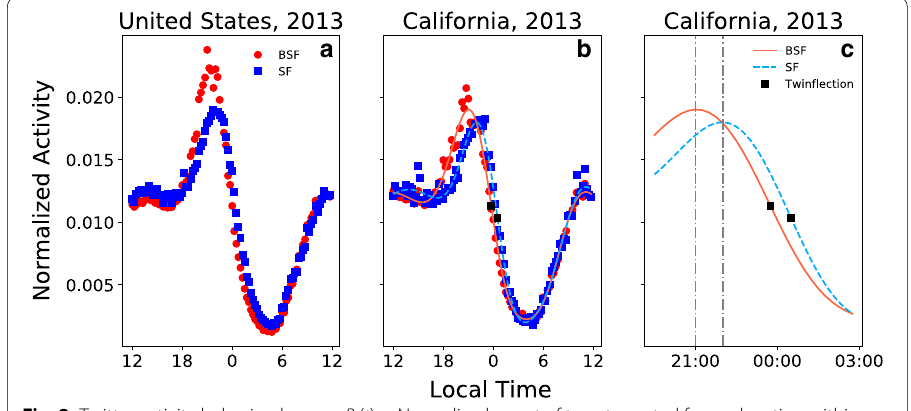
Fig. 2 Twitter activity behavioral curves B ( t ). a Normalized count of tweets posted from a location within the United States between 12 p.m. Sunday and 12 p.m. Monday before (red) and the week of (blue) the 2013 Spring Forward Event. The time recorded for the tweet is that local to the author. Though the pattern of behavior is preserved following Daylight Savings, peak activity is translated forward in time. b The same plot, with location of tweet origin restricted to the state of California. California is the state for which we have the most data, and therefore the most representative behavior profile after smoothing with Gaussian Process Regression (lines). We note that Fig. 5 shows behavioral curves for all states. c The smoothed behavioral pattern for California during the hours of 9 p.m. to 3 a.m. Pacific Time. Activity peaks are denoted by vertical dashed lines, and twinflection points are marked by squares. To estimate the behavioral shift in time, we compute the distance along the temporal axis between these pairs of lines/points. California’s BSF peak is 1 h earlier than the SF